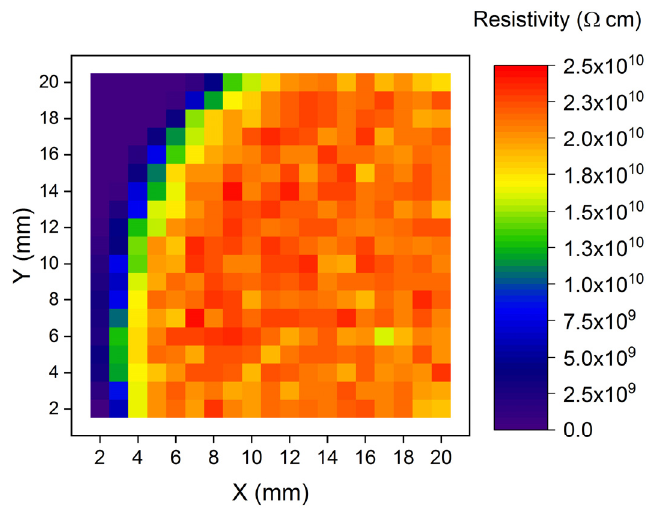
Figure 4. Resistivity map of a (Cd,Mn)Te:In sample measured by the EU- ρ - μτ -SCAN apparatus. The upper left corner is the border of the sample (and of the crystal). The side surface leakage current influences the measured sample resistivity up to about 3 mm from the side.